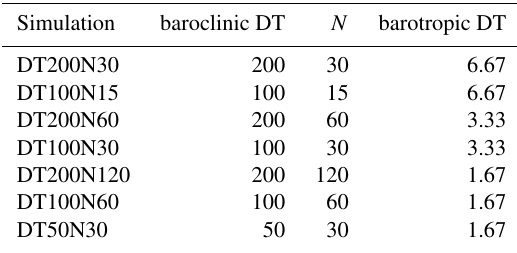
Table A1. Experiments with different combinations of barotropic and baroclinic time step sizes. N is the number of barotropic time steps between each baroclinic time step.